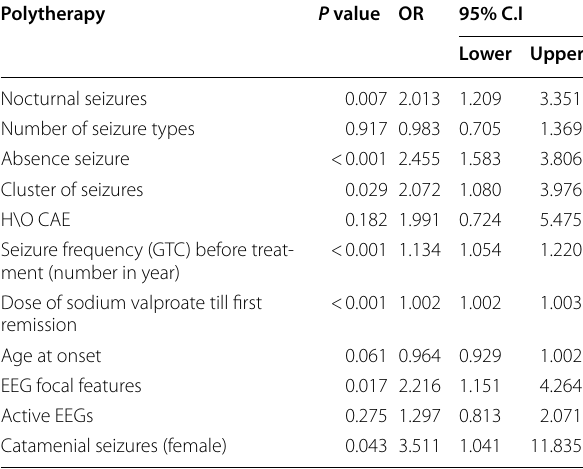
CAE childhood absence epilepsy, GTCs generalized tonic clonic seizures, EEG electroencephalogram , OR odds ratio , CI confidence interval